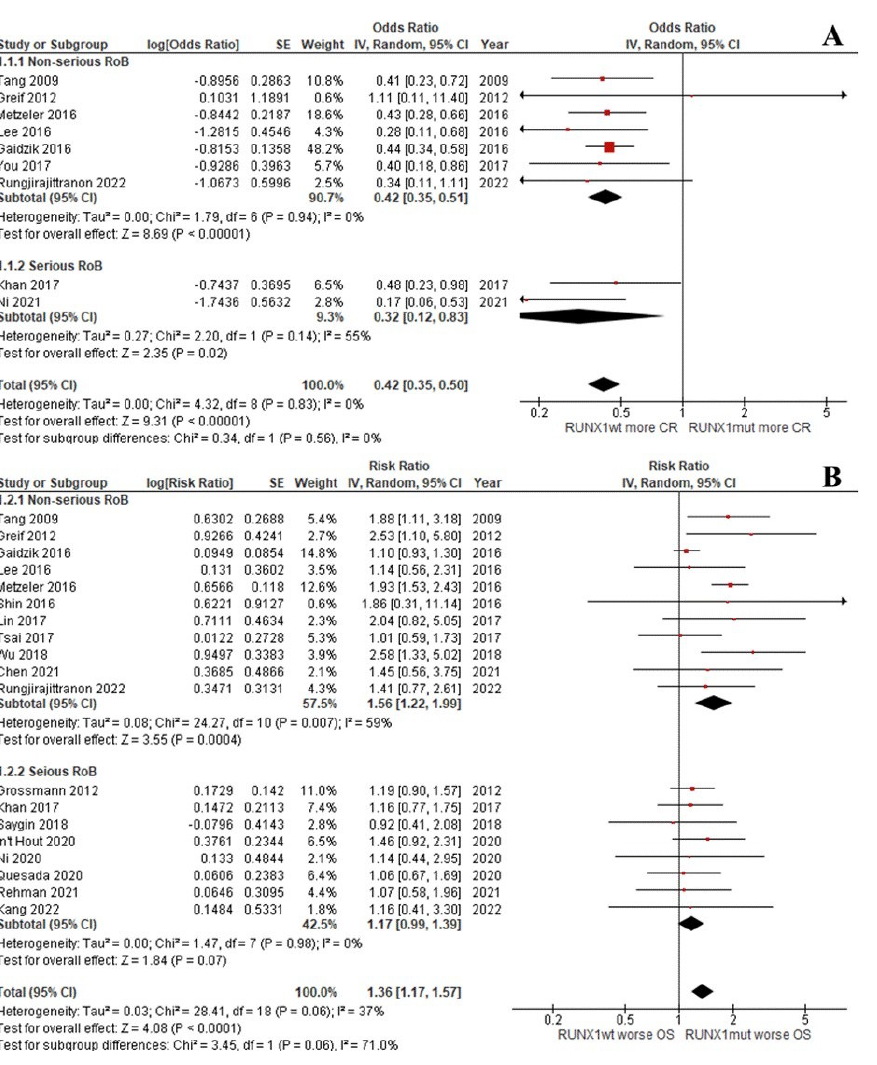
Figure 2. Forest plot of the clinical outcomes of the RUNX1 mut and RUNX1 wt AML patients: ( A ) CR rate; ( B ) OS.